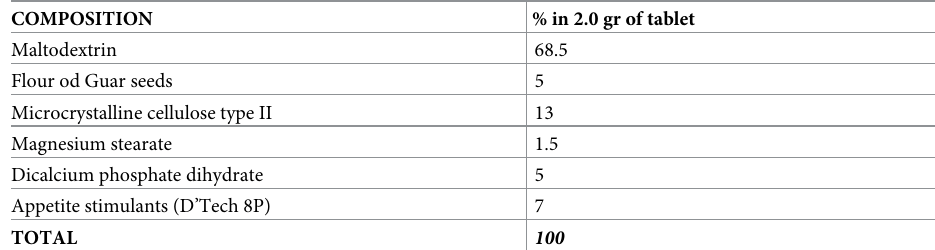
Table 1. Composition of the placebo used during the